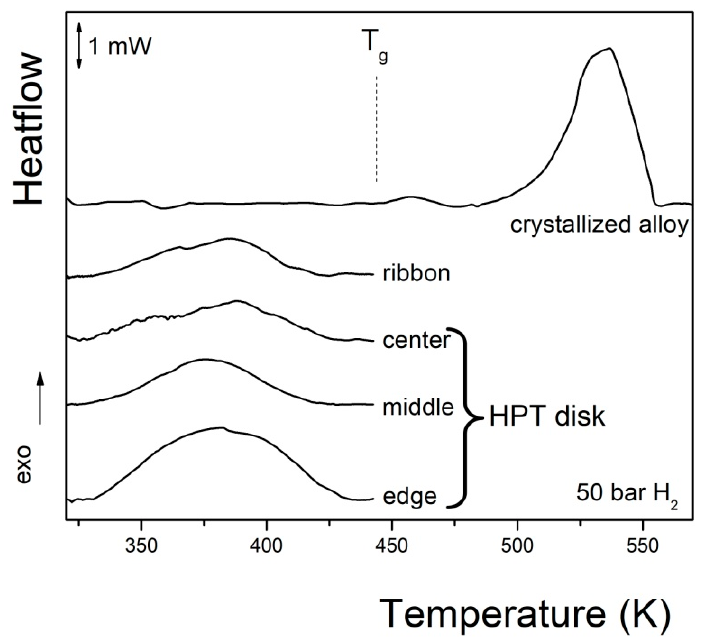
Figure 9. High-pressure DSC measurements on the reference Mg 65 Ni 20 Cu 5 Y 10 crystalline sample, the fully amorphous ribbon, and different deformation states of the HPT-disk [117] .